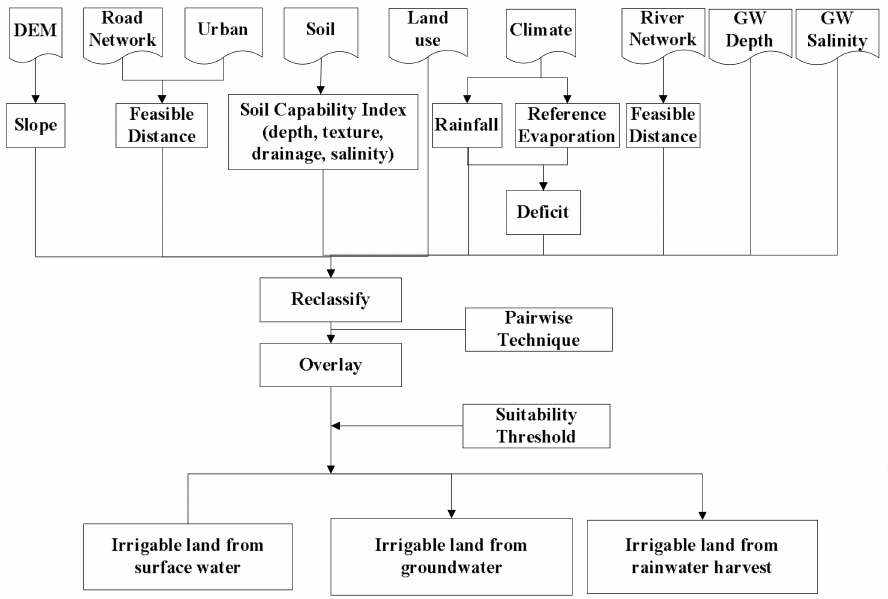
Figure 2. Method of identifying suitable land for irrigation (GW stands for